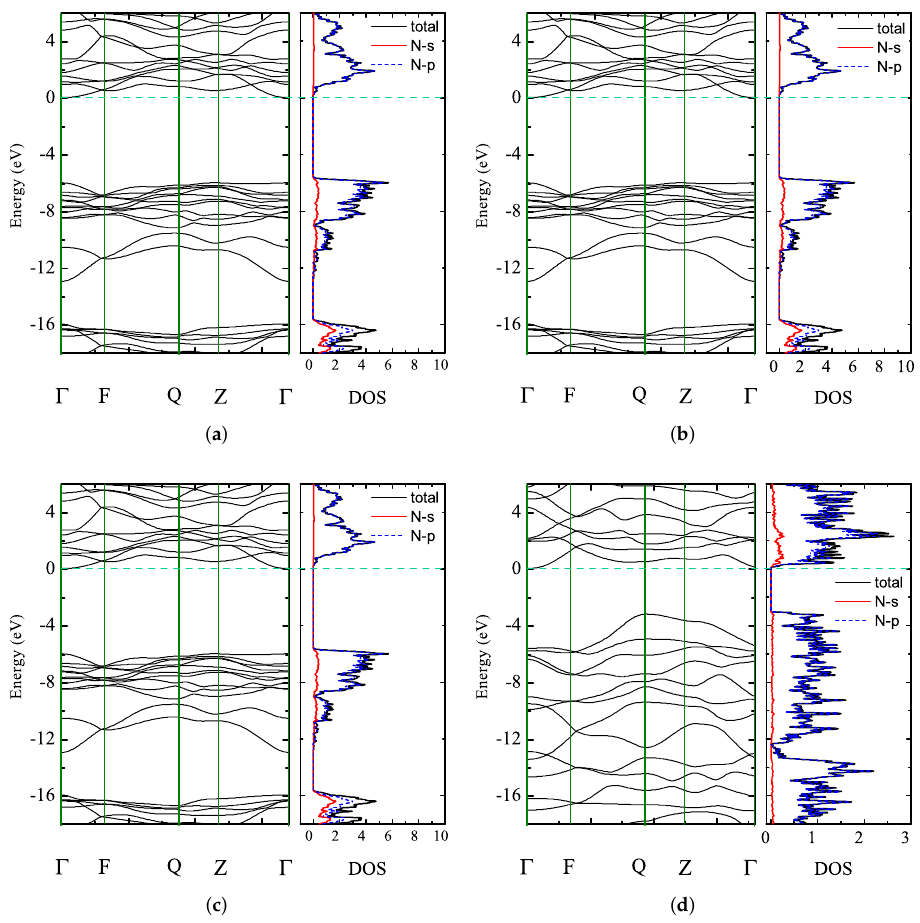
Figure 8. Band structures and DOS of 2-Td-N 4 : ( a ) 0 GPa, ( b ) 100 GPa, ( c ) 200 GPa, ( d ) 430 GPa. Fermi level E F was set at zero; horizontal green dashed line denotes the energy positions of the conduction band